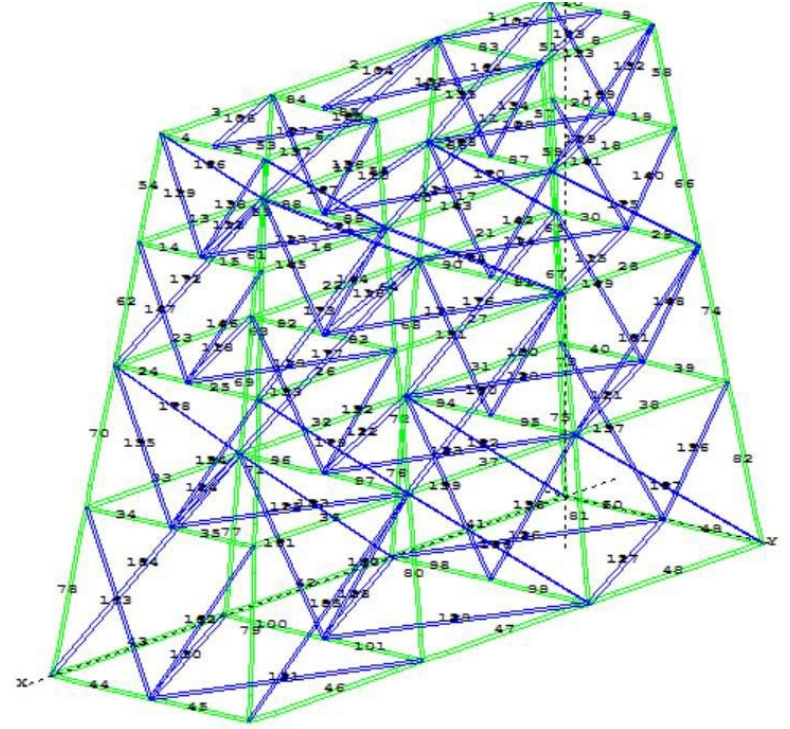
Figure 1. Three-dimensional view of the fixed-base jacket platform. Each element was modeled as a beam-column member with a circular thin-wall cross section.